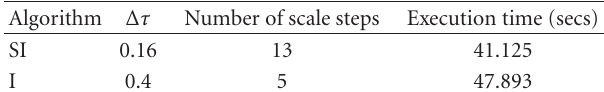
Table 6: Convergence history of Algorithm SI. Δ τ I = 0 . 4. First Table 7: Convergence history of Algorithm SI. Δ τ I = 0 . 04. First